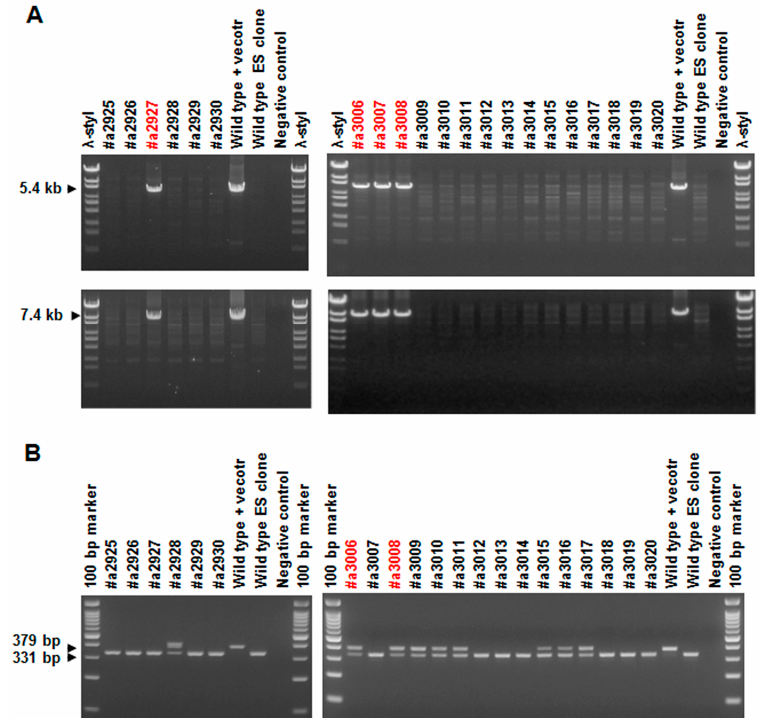
Table 1. Obtained heterozygous floxed ( Agtrap fl/- ) mice were further mated with Agtrap fl/- mice to generate homozygous floxed ( Agtrap fl/fl ) mice.